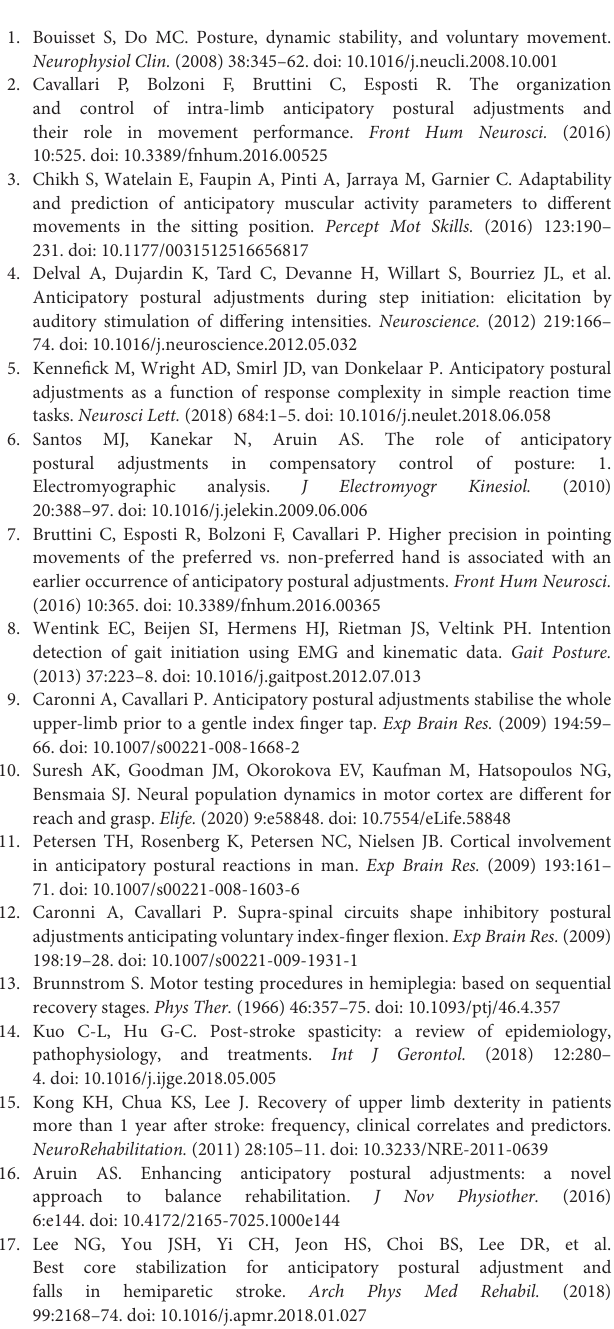
main effects of the 3 fixed factors (3 move sides, 2 stimuli conditions, and 3 move tasks) in different variables were provided. The post-hoc comparisons with Bonferroni corrections under each fixed factor with significant main effects in its model were provided after each liner model. H, N, and P represent healthy, non-paretic, and paretic sides, respectively. R, B, and C represent the move task reach, reach to grasp a ball, and reach to grasp a cup, respectively. N/A means not